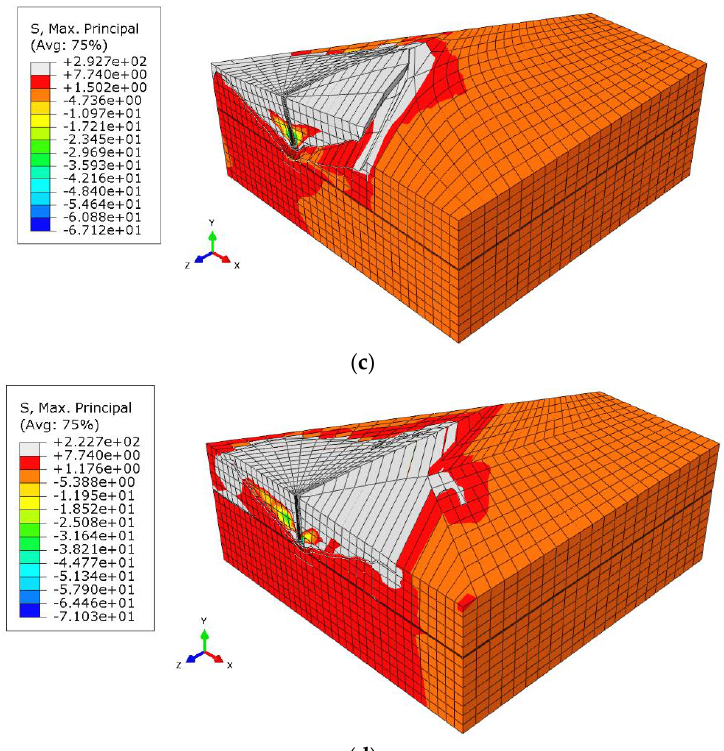
Figure 8 . Maximum principal stress distribution and crack propagation in the models (magnified deformations). Radius r i : ( a ) 115.47 mm, ( b ) 230.94 mm, ( c ) 346.41 mm, ( d ) 404.14 mm. Effective embedment depth h ef = 150 mm.